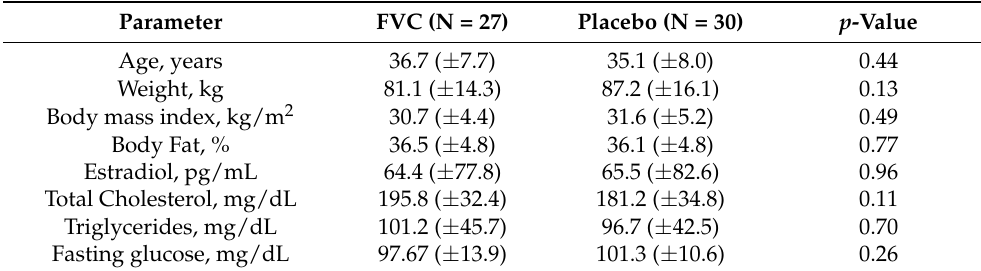
Table 1. Characteristics of subjects at